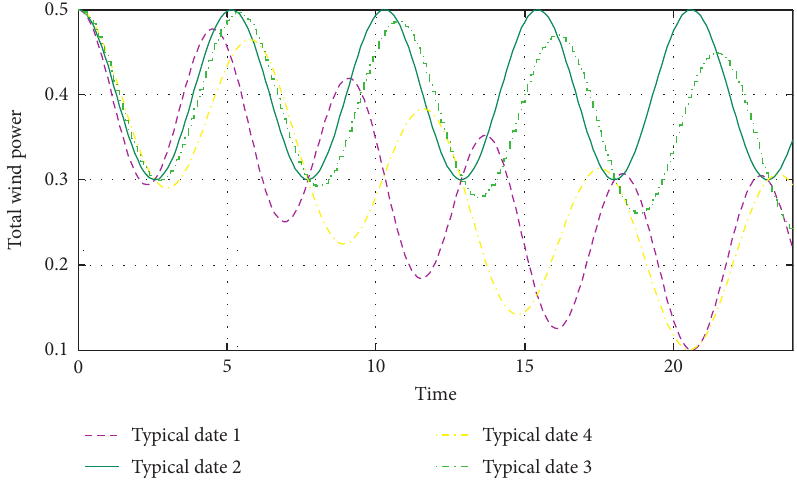
Figure 6: Total wind power generation.